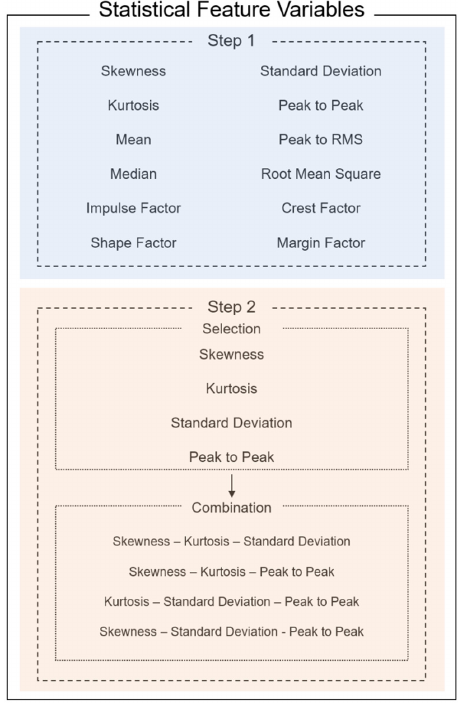
Figure 2. Feature engineering for feature combination matrix.